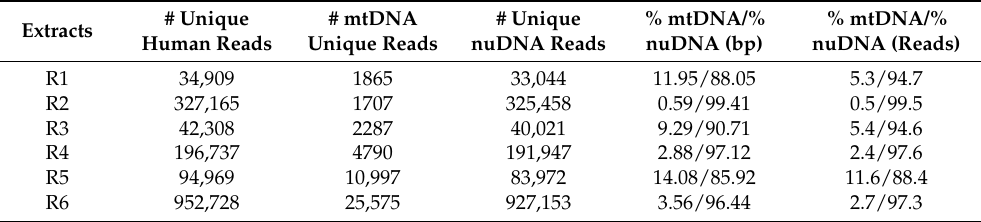
Table 11. Sequencing statistics for recent single